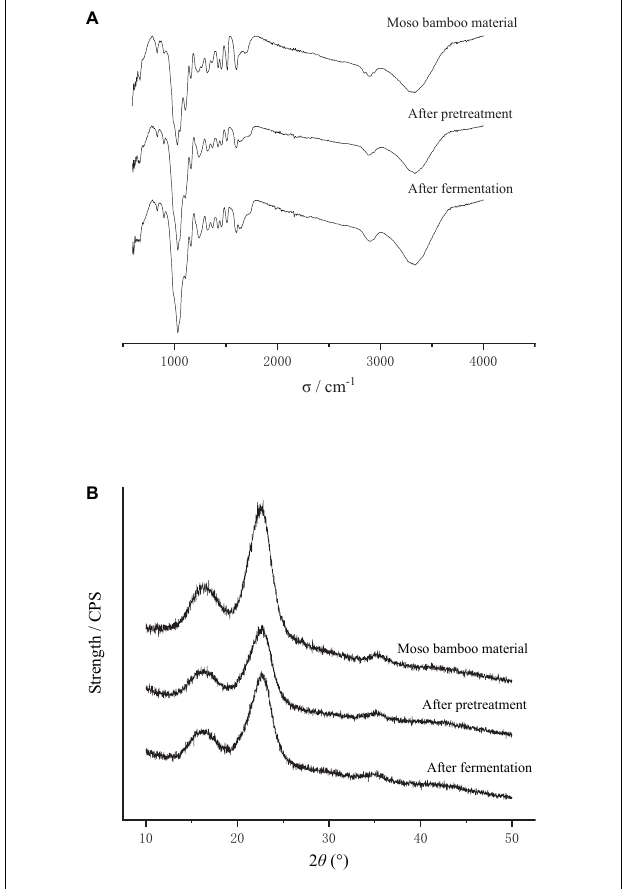
FIGURE 5 | Effect of pretreatment and T334 fermentation on the microstructure of moso bamboo. (A) Infrared spectrum of moso bamboo pretreated by disk mill and after fermentation. Samples of the moso bamboo raw material, after pretreatment and after fermentation were scanned with a Nicolet iS10 Fourier Infrared Spectrometer, and the wavelength was 500–4,000 cm − 1 . Each sample was scanned three times, and the result was the average of three times. (B) X-ray diffraction pattern of moso bamboo pretreated by disk mill and after fermentation. Samples of the moso bamboo raw material, after pretreatment and after fermentation were scanned with a D8 Foucus X-ray Diffraction instrument. The detection wavelength was 0.15406 nm, and the sampling interval was 0.02 ◦ . Each sample was scanned three times, and the result was the average of three